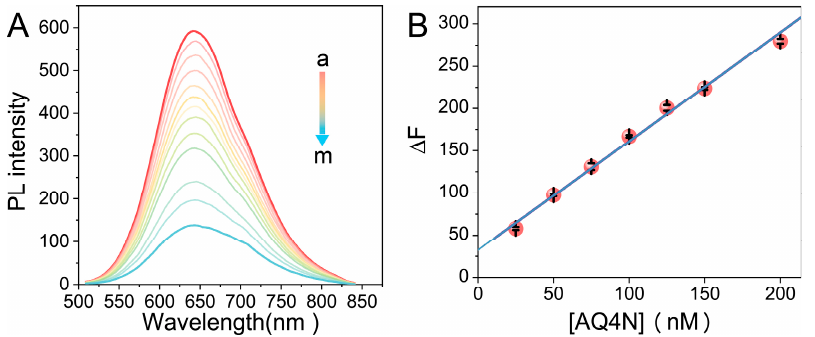
Figure 4. ( A ) The photoemission spectra of CC/DTT-AuNCs in the presence of various amounts of AQ4N. From a to m: 0, 25, 50, 75, 100, 125, 150, 175, 200, 250, 400, 500, and 750 nM. ( B ) Δ F as a function of AQ4N concentration.